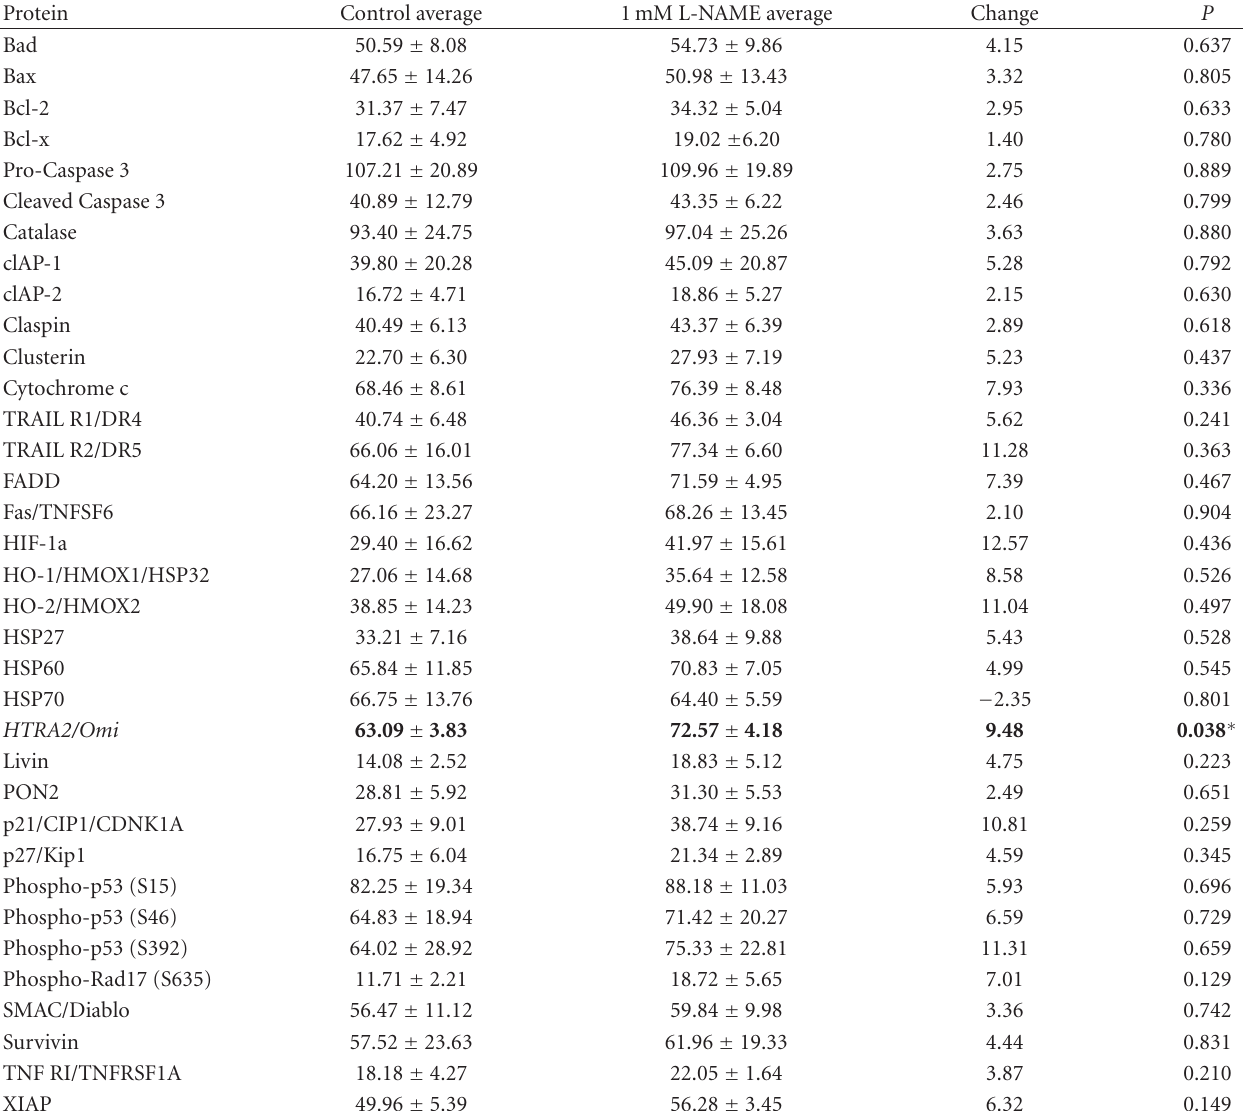
Table 2: Protein levels of 35 apoptosis-related proteins after treatment of VSMCs with 1 mM L-NAME.